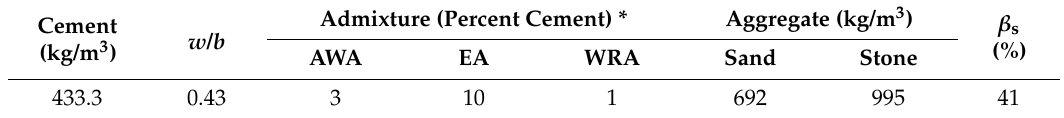
Table 10. The basic mix ratio of SSAWC.